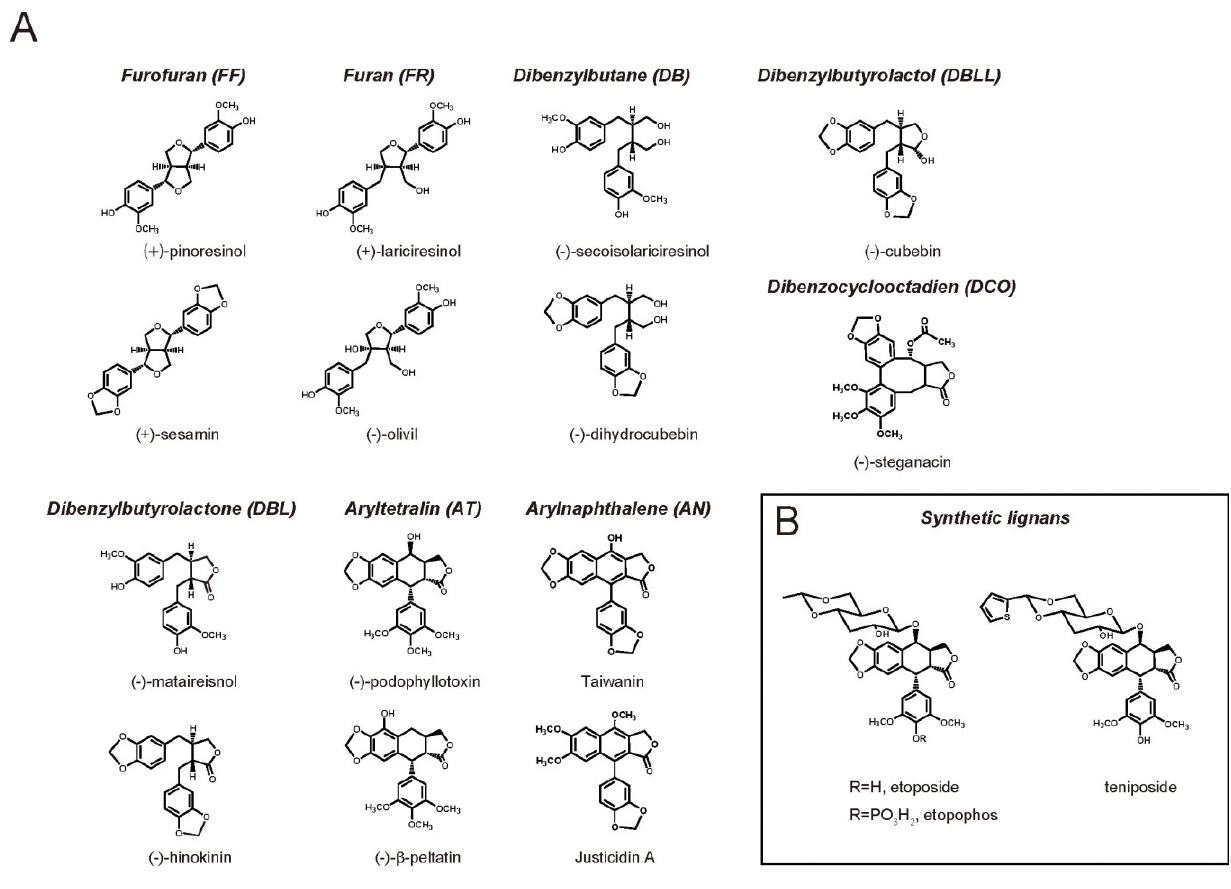
Figure 1. Chemical Structures of Typical Lignans in ( A ) Dietary and Medicinal Sources and ( B ) Synthetic Podophyllotoxin